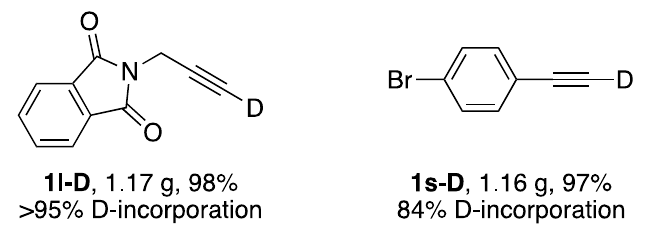
Figure 2. Gram-scale deuteration reactions.